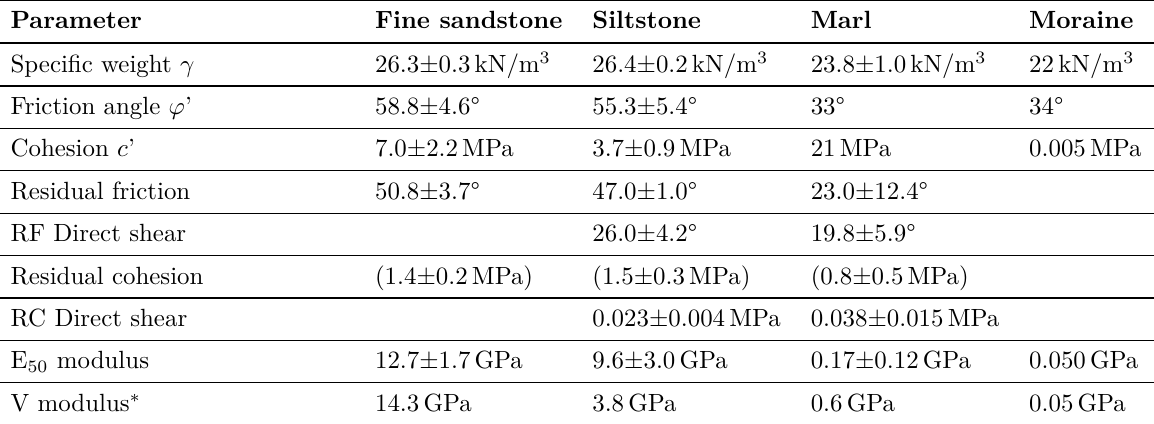
Table 1. Rock properties (triaxial and direct shear).